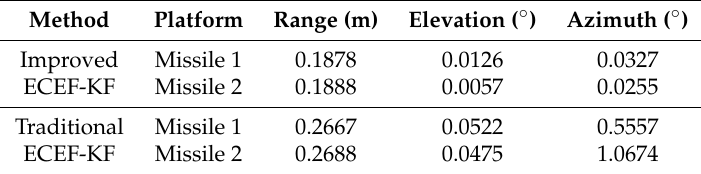
Table 1. RMSE of registration